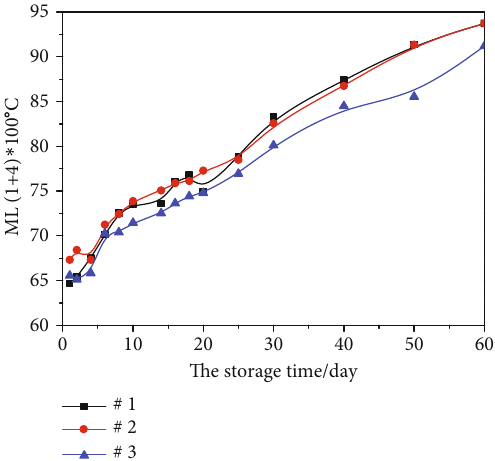
Figure 2: The Mooney viscosity variation of the reclaimed rubber samples with storage time. The Mooney viscosity values of the reclaimed rubbers increase with increasing storage days, but Mooney viscosity values are similar for di ff erent reclaimed rubber